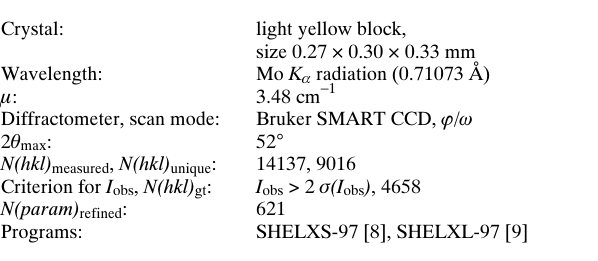
Table 1. Data collection and